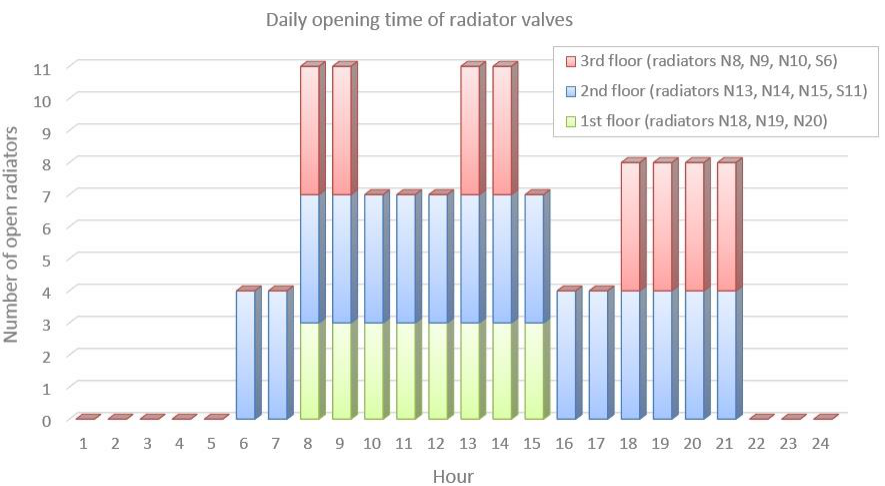
Figure 7. Programmed daily opening time of radiator valves.